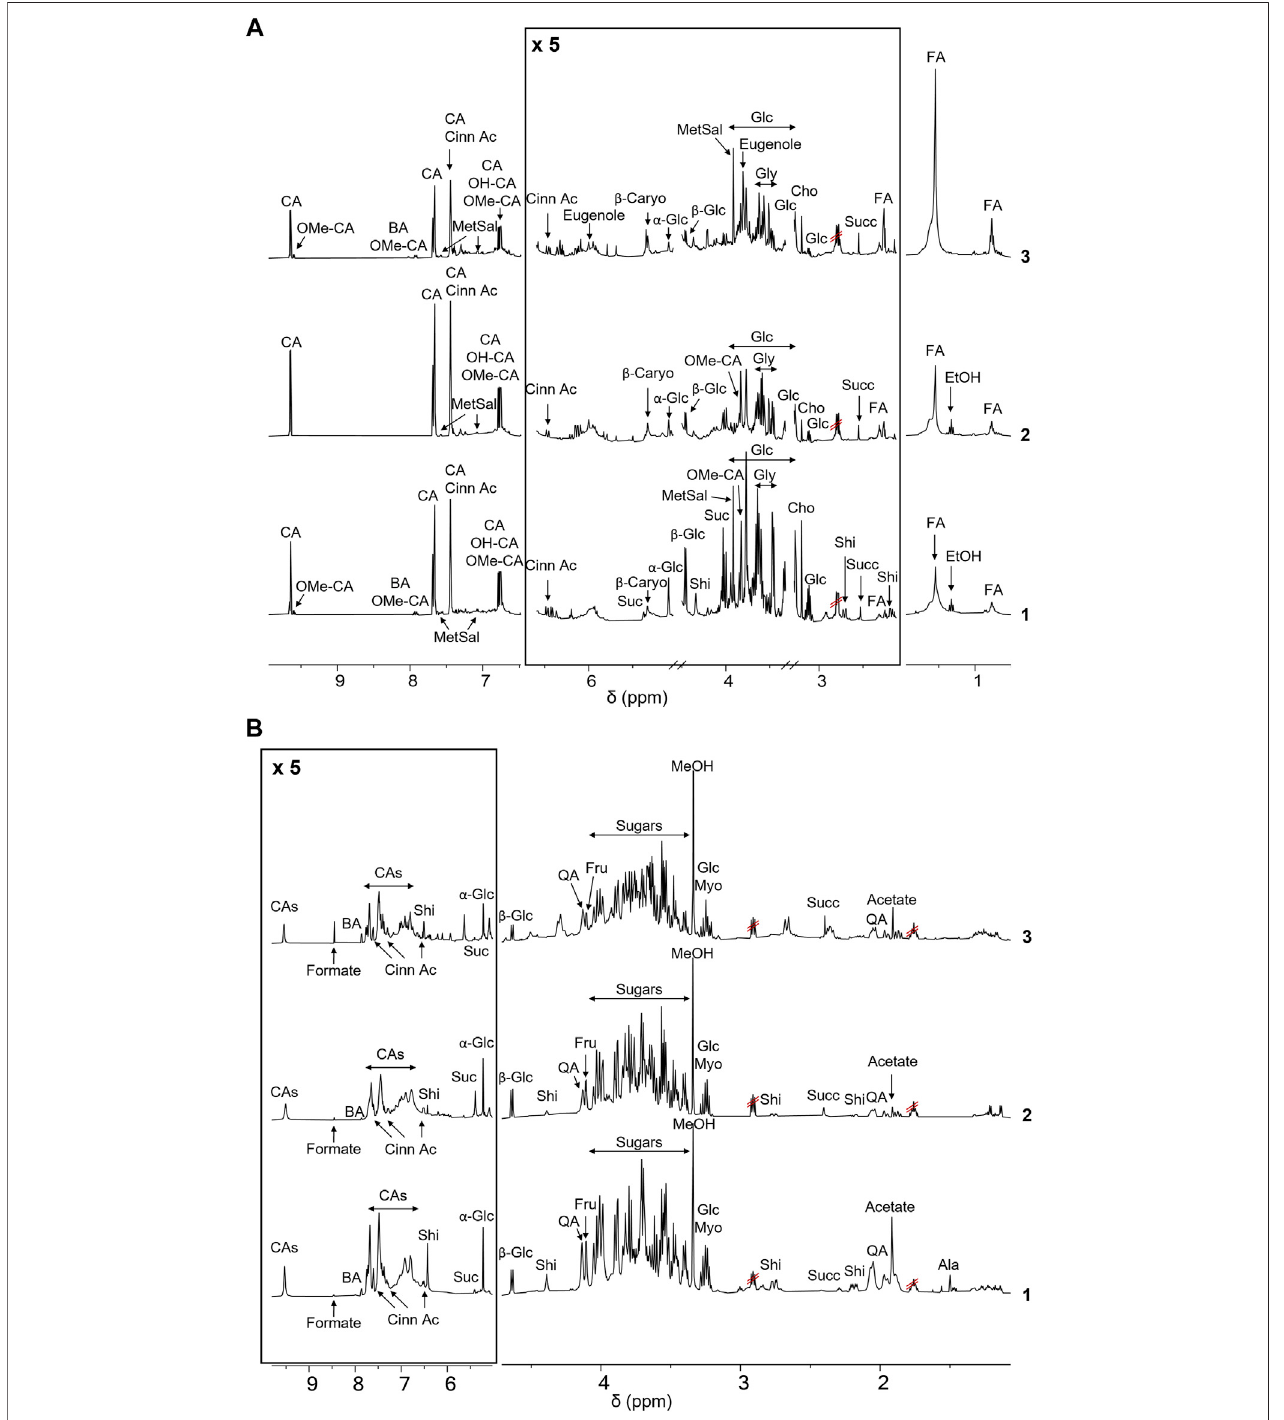
FIGURE 1 | NMR-based metabolic pro fi ling of cinnamon extracts. (A) 1 H-NMR spectra of the ethanol extracts of cinnamon buds 1 ) and bark 2 , C. cassia ; 3 ) C. zeylanicum )samples. Each sample containing15 mg/ml ofextract, wasdissolved in CD 3 OD, DSS 1 mM. Spectra wereacquiredat 25 ° C and 600 MHz. Assignmentsof the resonances of the most important metabolites are reported (CA (E)-Cinnamaldehyde; OMe-CA, 2-Methoxycinnamaldehyde; BA, Benzoic Acid; Cinn Ac, Cinnamic Acid;OH-CA,2-Hydroxycinnamaldehyde;MetSal,MethylSalicylate; β -Caryo, β -Caryophyllene;Suc,Sucrose;Glc,Glucose;Shi,ShikimicAcid;Gly,Glycerol;Cho, Choline; Succ, Succinate; FA, Fatty Acid). (B) 1 H-NMR spectra of the aqueous extracts of buds ( 1 ) and bark (2, C. cassia; 3, C. zeylanicum ) samples. Each sample, containing15 mg/mlofextract,wasdissolvedinD 2 O,pH7.2,andDSS1 mM.Spectrawereacquiredat25 ° Cand600 MHz.Assignmentsoftheresonancesofthemost important metabolites are reported (CAs (E)-Cinnamaldehyde and derivatives; BA, Benzoic Acid; Cinn Ac, Cinnamic Acid; Suc, Sucrose; Glc, Glucose; Shi, Shikimic Acid; QA, Quinic Acid; Fru, Fructose; Myo, Myo -inositol; Succ, Succinate).